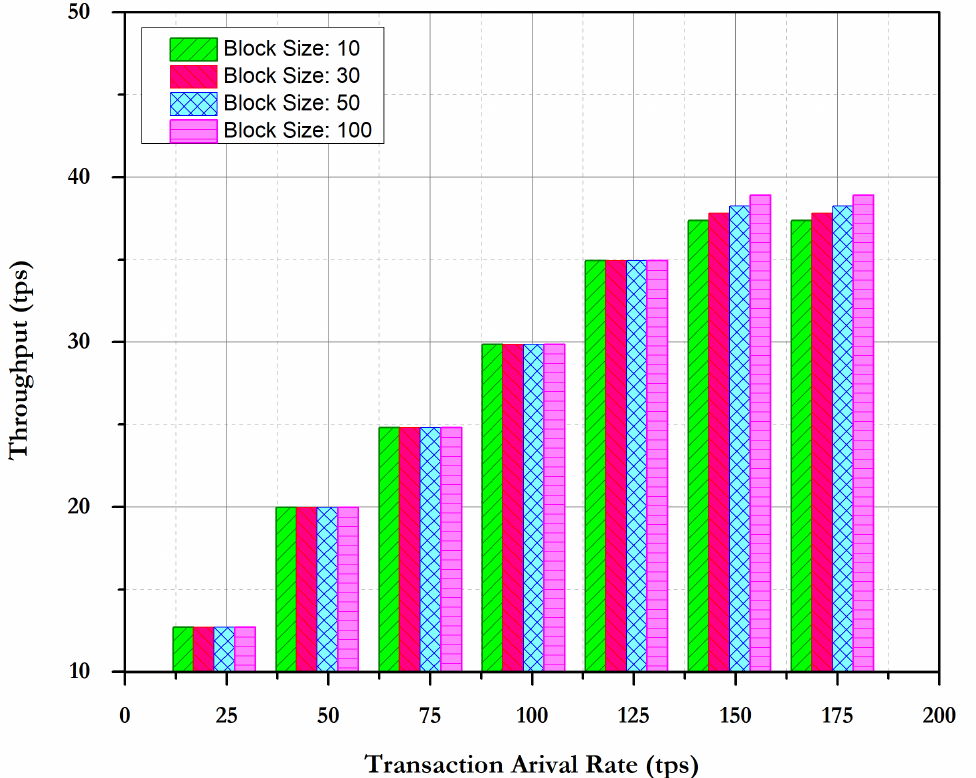
Figure 6. Throughput Performance of the deployed Hyperledger with various sized